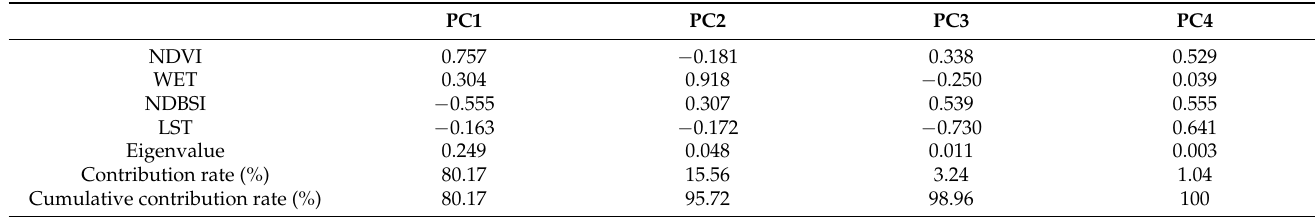
Table 5. Principal component analysis results of remote sensing ecological index in